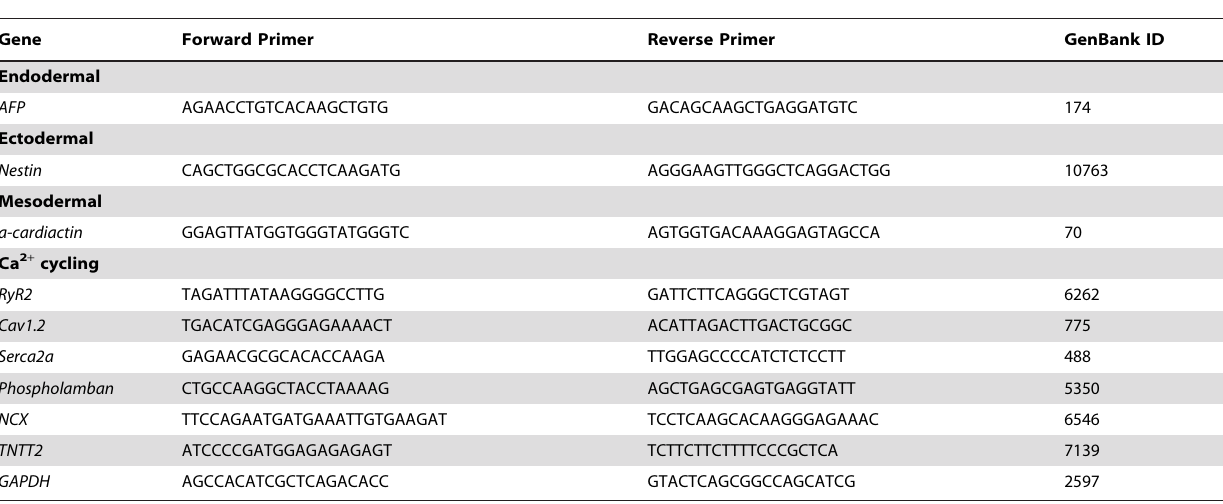
Table 1. Primer sequences for